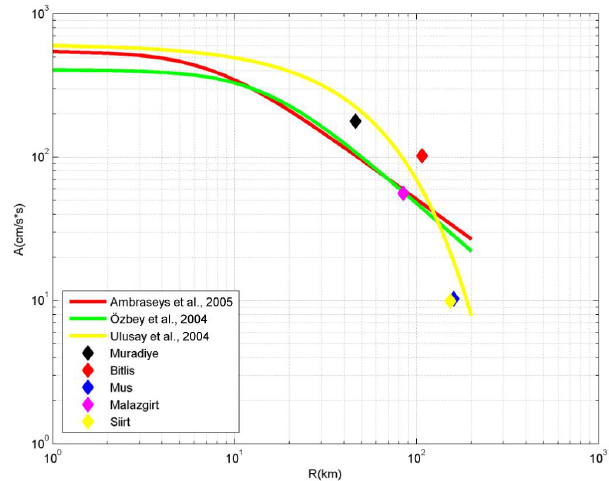
Fig. 4. Comparison of recorded strong ground motions with ground Figure 4. Comparison of recorded strong ground motions with GMPEs. 2 motion prediction